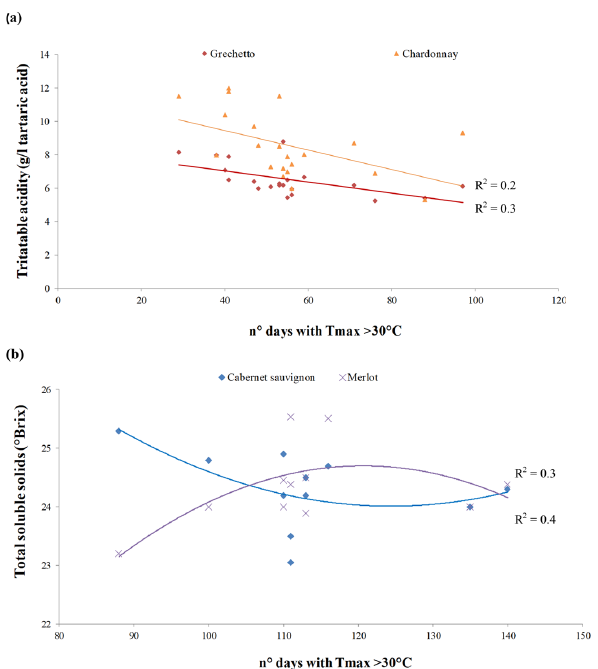
Figure 7. Berry quality and extreme temperature events; ( a ) titratable acidity (g ∙ L − 1 tartaric acid) for the white varieties affected by the number of days with maximum temperature (Tmax) equal or exceeded to 30 °C during the growing season; and ( b ) total soluble solids (°Brix) for the varieties Cabernet sauvignon and Merlot related to the number of days with maximum temperature (Tmax) equal or exceeded to 30 °C during the growing season.